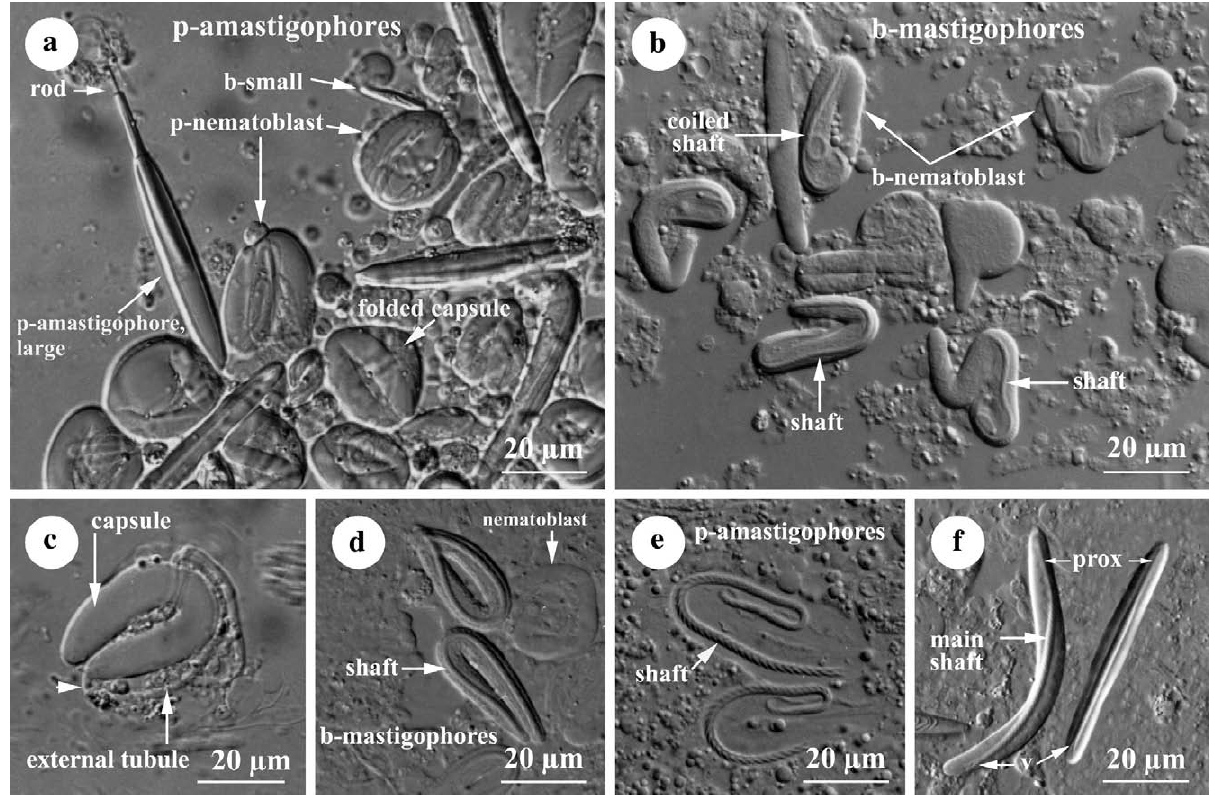
Fig . 4. – Differentiation in acontia nematocysts. a,c,e,f) p-amastigophores, large. b,d) b-mastigophores, large. a-c) Late nematoblasts from proliferation zones near acontium base. a) p-amastigophores. Note folded U-shaped capsule and external tubule. b) b-mastigophores, show- ing inverted shafts within folded capsules. c) p-amastigophore, showing connection between external tubule and U-shaped capsule (small arrow). d) b-mastigophores; U-shaped capsules and shafts, later than in b). Note capsule with external tubule. e,f) p-amastigophores showing differentiation of shaft. e) 2 late nematoblasts; folded shaft with spine pattern. f) Capsules immature but no longer U-shaped. Shaft differenti- ated in proximal (prox) and main shaft with helices and V-shaped notch at its end. b-nematoblast , nematoblast of b-mastigophore; b-small , b-mastigophores, small; p-nematoblast , nematoblast of p-mastigophore; prox, proximal shaft; v, V-shaped notch at shaft